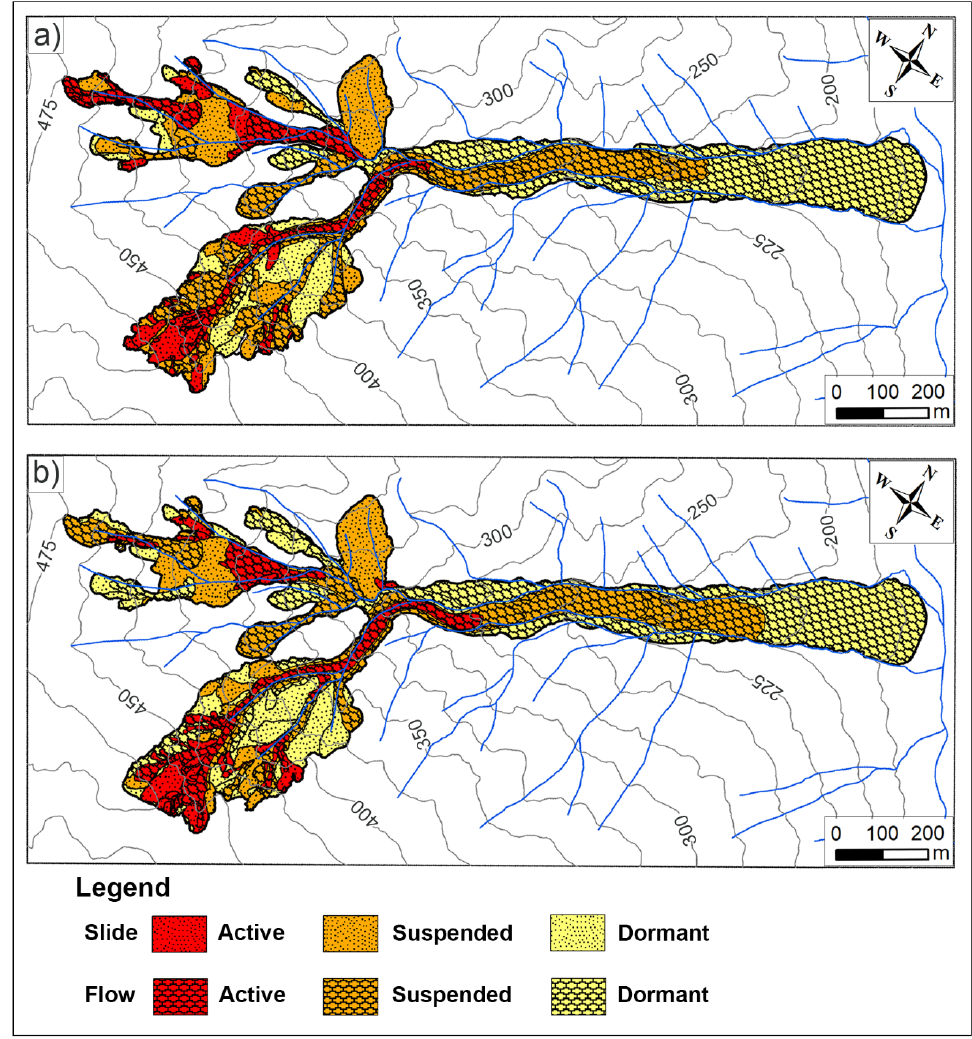
Figure 8. Vomice landslide inventory map at February 2019 ( a ) and June 2022 ( b ). Table 3. Spatial distribution of the mass movements (in ha and in percentage with respect to the total area) in the Vomice landslide in 2019 and